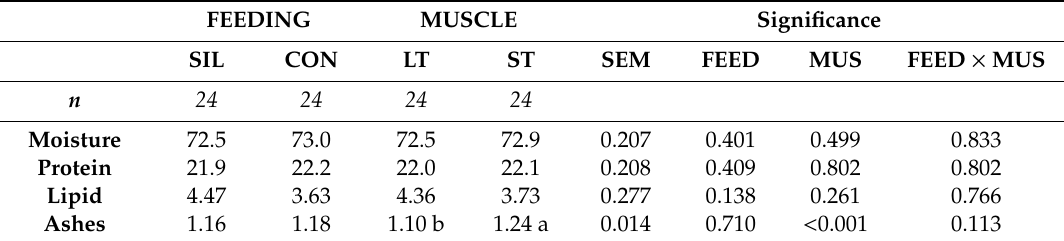
Table 3. E ff ect of feeding (concentrated (CON) and 70% maize silage + 30% concentrate (SIL)) and muscle ( Longissimus thoracis (LT) and Semitendinosus (ST)) on proximate analysis of meat from Avileña-Negra Ib é rica breed. FEEDING MUSCLE Significance SIL CON LT ST SEM FEED MUS FEED × MUS 24 Moisture 72.5 73.0 Protein 21.9 22.2 22.0 4.47 4.36 0.766 Ashes